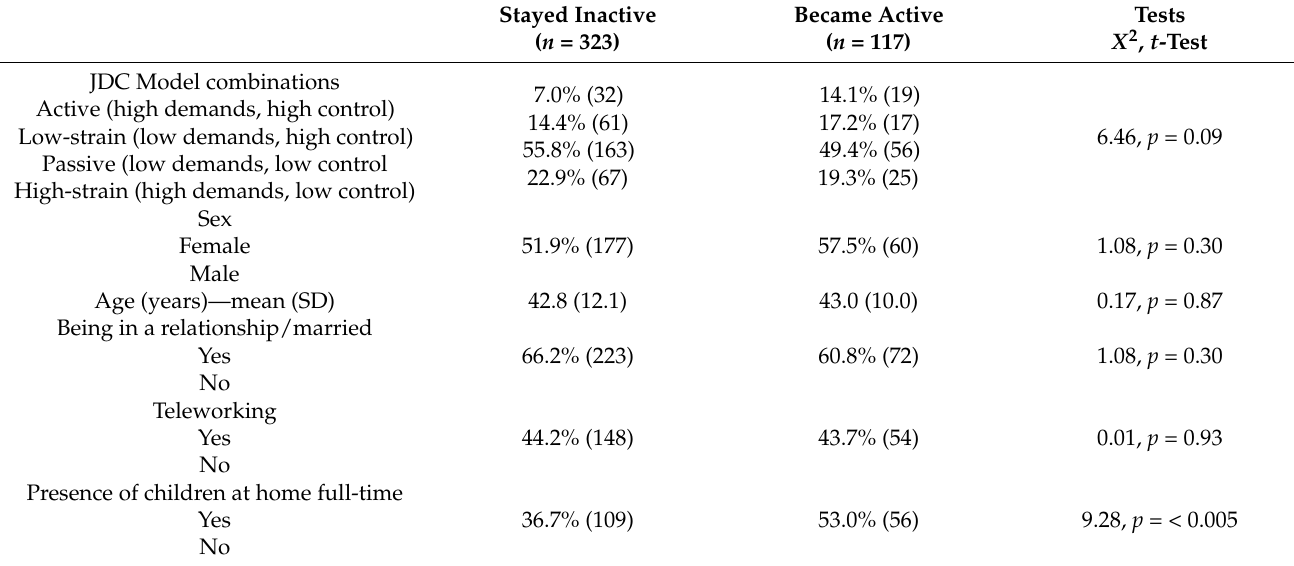
Table 1. Descriptive statistics according to physical activity